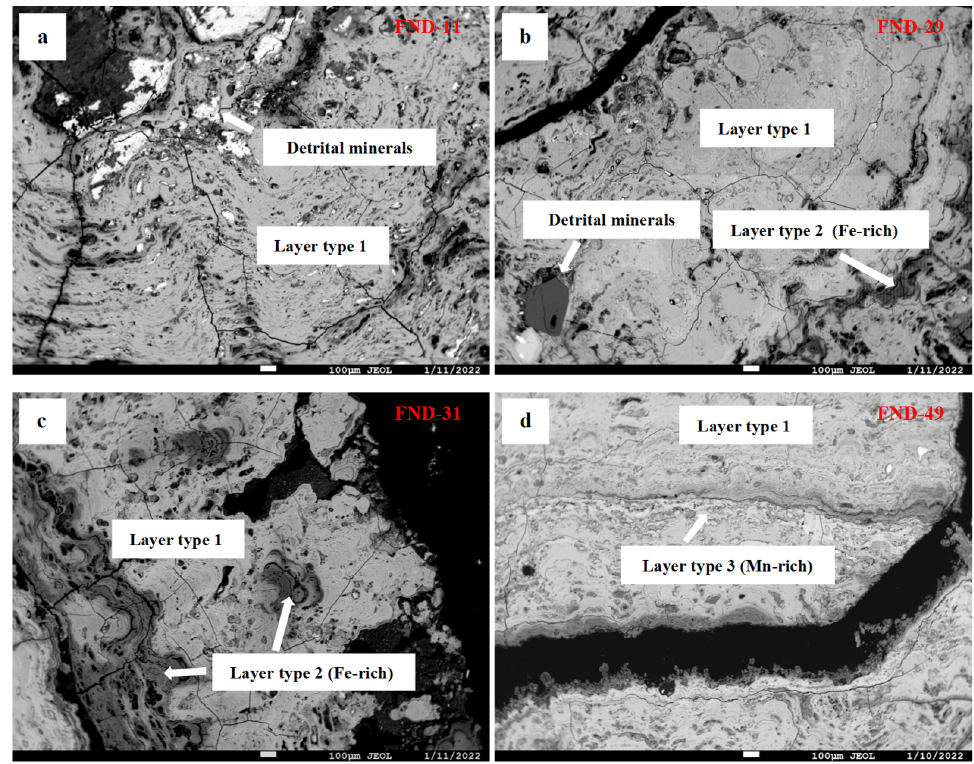
Figure 2. ( a – d ): BSE images of three layer types of nodules from the Philippine Sea. Table 2. Average element content of individual layers (EMPA data;